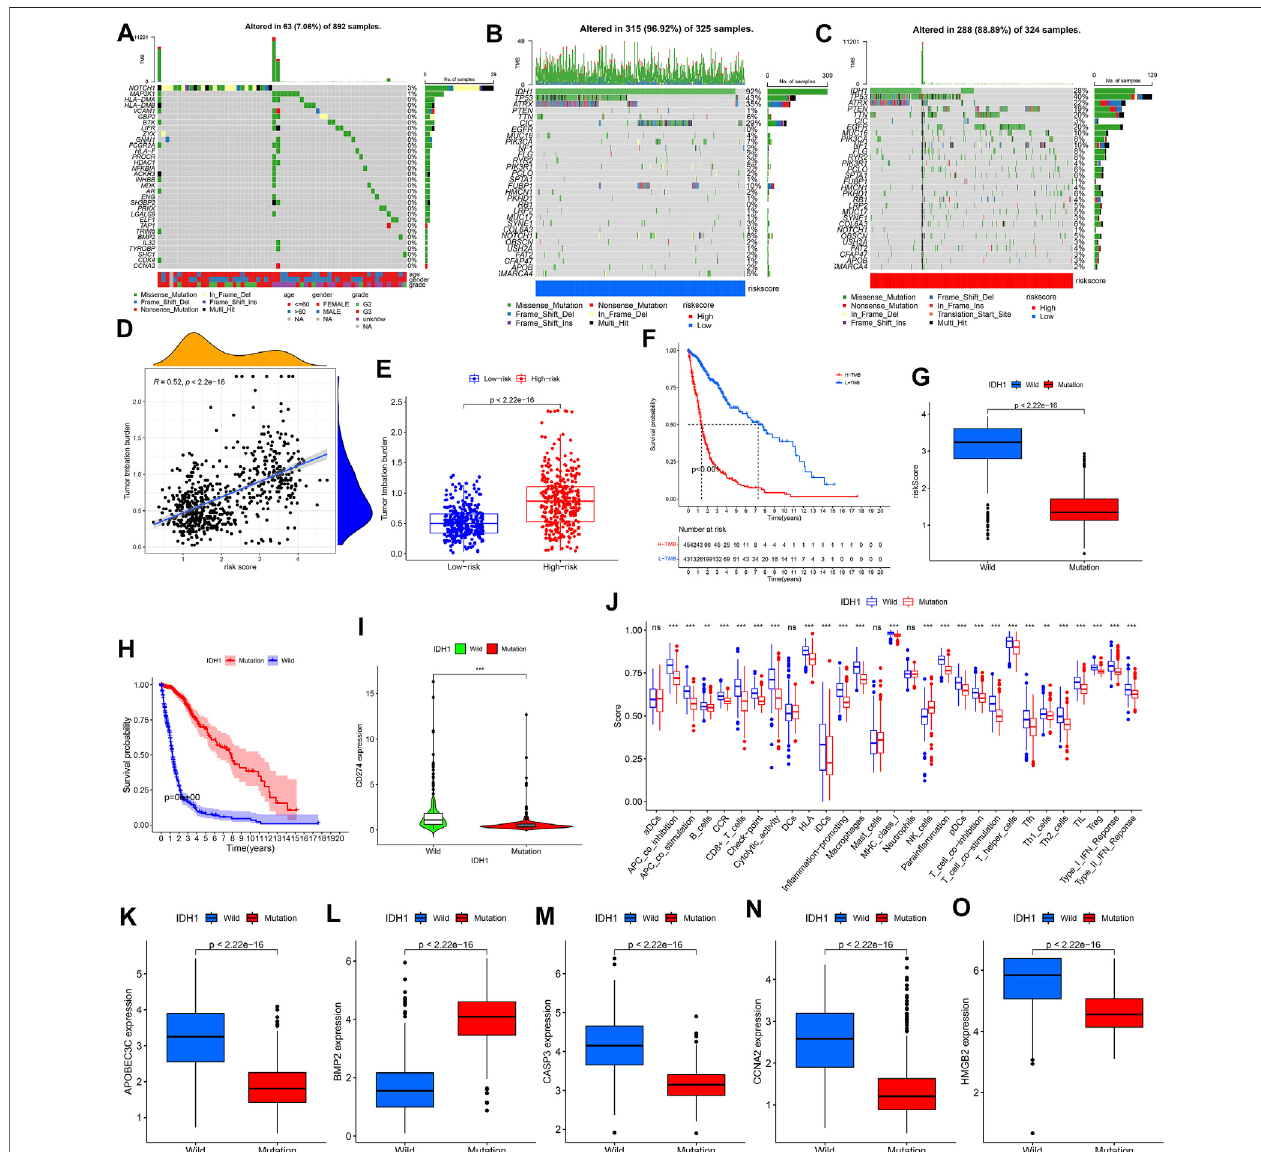
FIGURE9 | Mutation analysis. (A) Waterfall plot re fl ecting the statistical results ofmutations in 32mutated DE-IRGs highly associatedwithgliomas. (B , C) Waterfall plots visualizing the statistical results of these 30 genes ’ mutation in different risk groups. The right panel of the waterfall plot showing the mutation frequency. The different colors at the bottom of the waterfall plot showing different mutation types and clinical characteristics types. The histogram above the waterfall plot showing the TMBstatisticalresultsforeachsample. (D) CorrelationanalysisresultsbetweenriskscoreandTMB. (E) TMBdifferencebetweenthehigh-riskandlow-riskgroups. (F) Difference in survival probability between high and low TMB groups. (G) Risk score difference between IDH1 mutant and wild-type group. (H) Difference in survival probability between IDH1 mutant and wild-type groups. (I , K – O) Expression difference of CD274/APOBEC3C/BMP2/CASP3/CCNA2/HMGB2 between IDH1 mutant and wild-type groups, respectively. (J) Difference in 16 immune cells and 13 immune functions between the IDH1 mutant and wild-type groups.